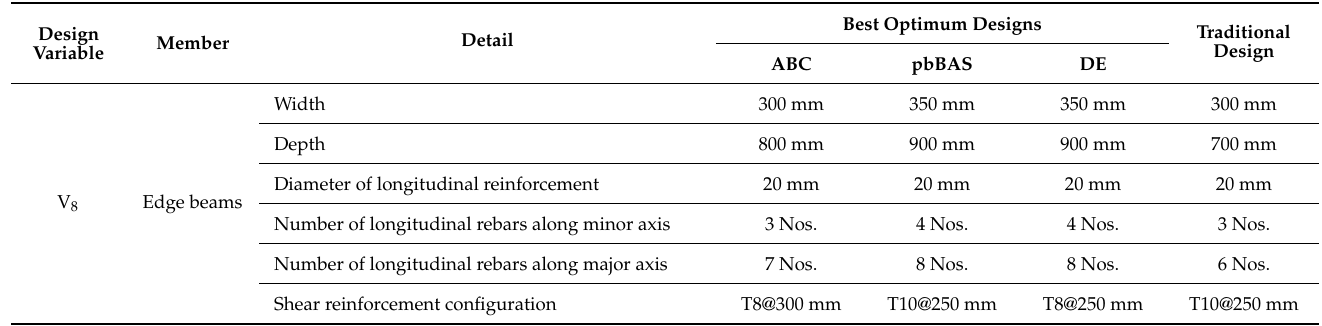
Table 16. The optimum values of auxiliary members variables obtained by each metaheuristic algorithm for the V-type folded plate roof